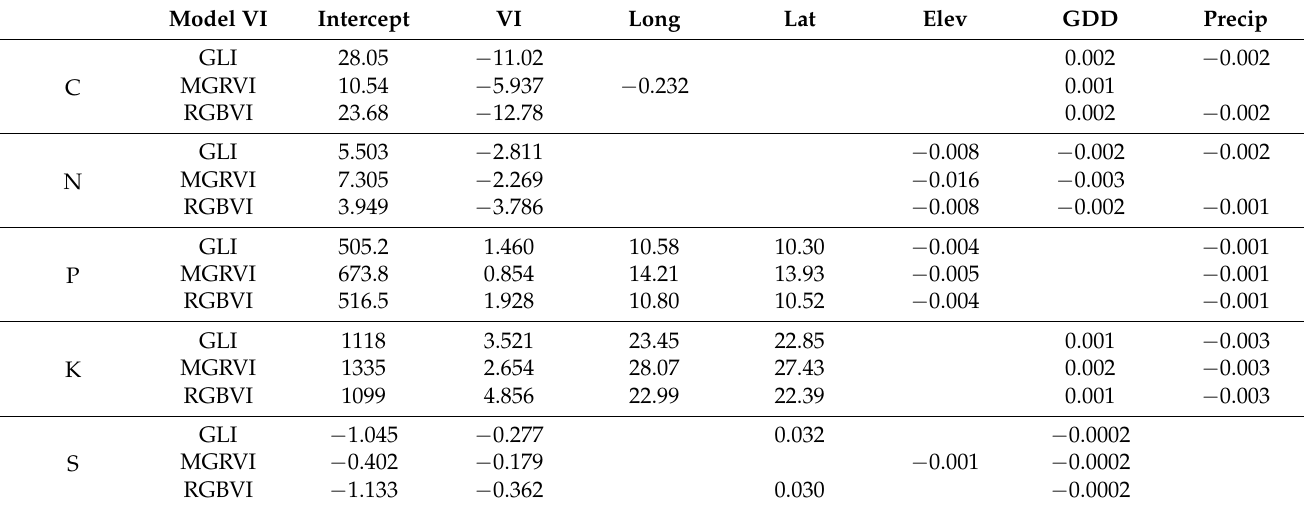
Table 8. Estimated regression coefficients for cereal rye carbon (C), nitrogen (N), phosphorus (P), potassium (K), and sulfur (S) concentration model parameters determined by forward stepwise multiple linear regression ( α = 0.05).